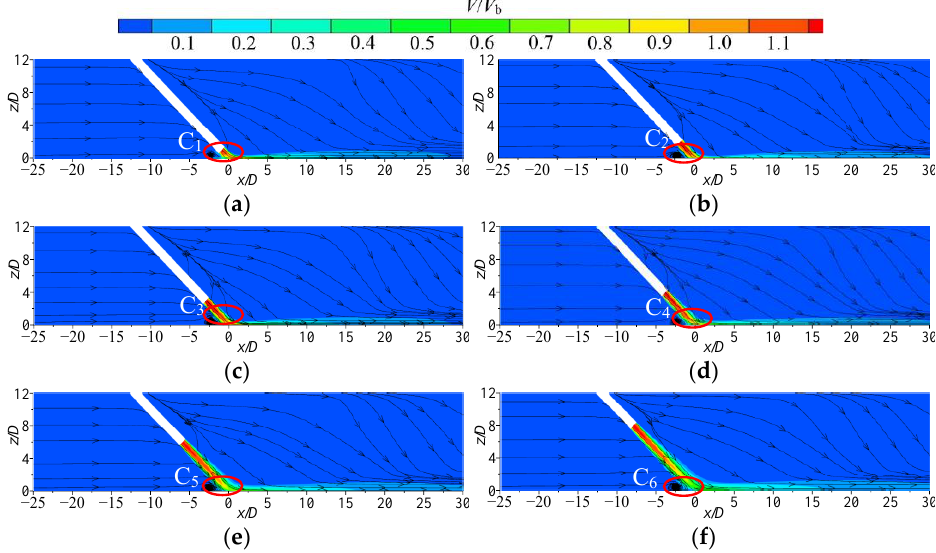
Figure 5. Normalized mean velocity V/V b cloud chart and streamline of mid-section at various impinging heights: ( a ) H/D = 1; ( b ) H/D = 2; ( c ) H/D = 3; ( d ) H/D = 4; ( e ) H/D = 6; ( f ) H/D = 8.